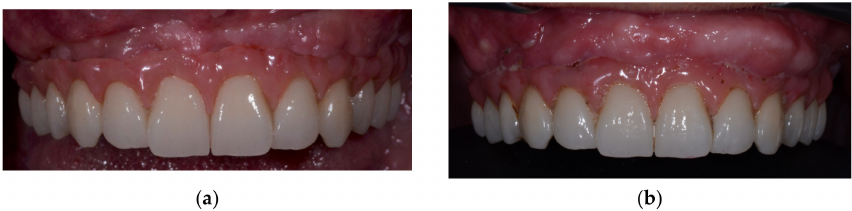
Figure 2. ( a )—Final prosthetic work in place; ( b )—final prosthetic work after 6-year follow up period.